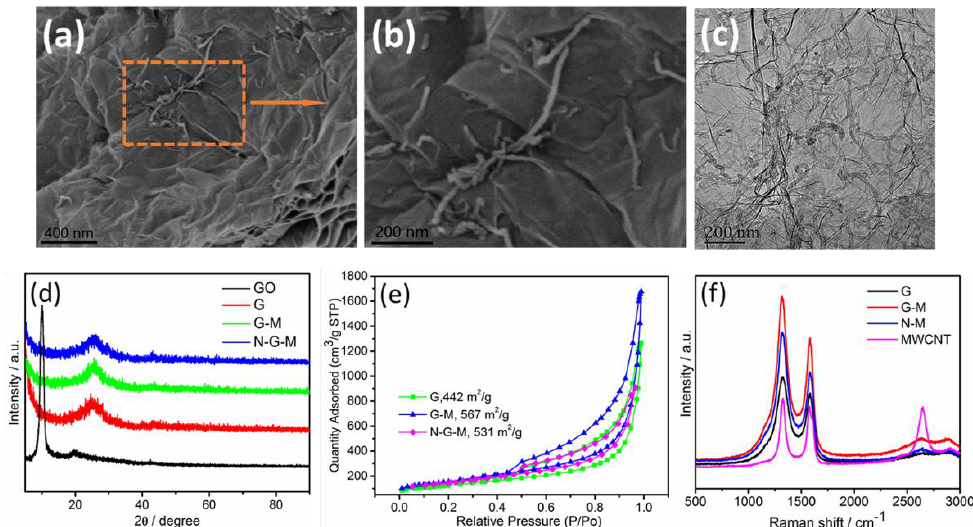
Figure 2. FESEM images for G-M ( a , b ); TEM image of G-M ( c ); XRD patterns of GO, G, G-M, and N- G-M ( d ); N 2 adsorption–desorption isotherms of G, G-M, and N-G-M supports ( e ); Raman spectra of MWCNT, G, G-M, and N-G-M supports ( f ).